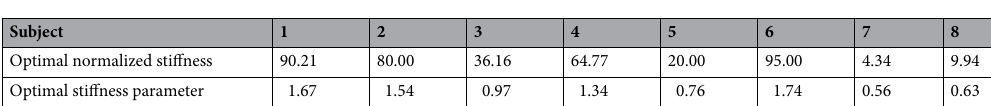
Table 1. Optimal stiffness parameter (third row) determined through HIL optimization (second row) for each subject (first row). The HIL optimization identified the normalized stiffness parameter (second row) and the corresponding stiffness parameter was used to control the